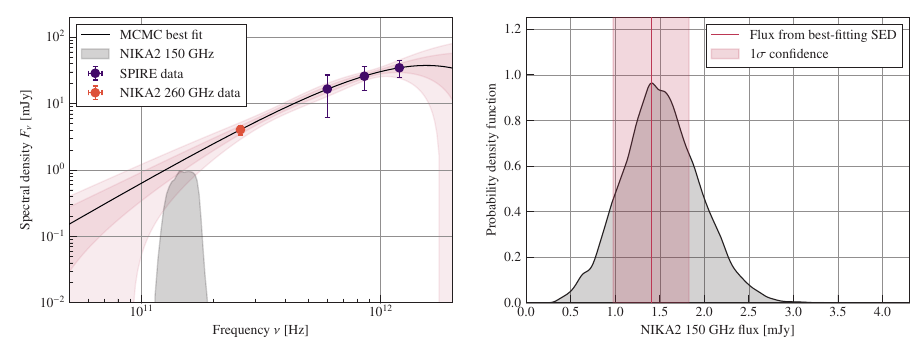
Figure 2. Results of the estimation of the contamination in the NIKA2 150 GHz map for one of the sources in our field. Left: SED results. The NIKA2 150 GHz point is extrapolated from the fit by integrating the SED distribution in the NIKA2 150 GHz bandpass. The black line marks the best-fitting SED, and the enveloppes show the 1 and 2 σ confidence intervals. Right: inferred probability distribution for the 150 GHz flux of the same source. The vertical line shows the flux computed from the best-fitting